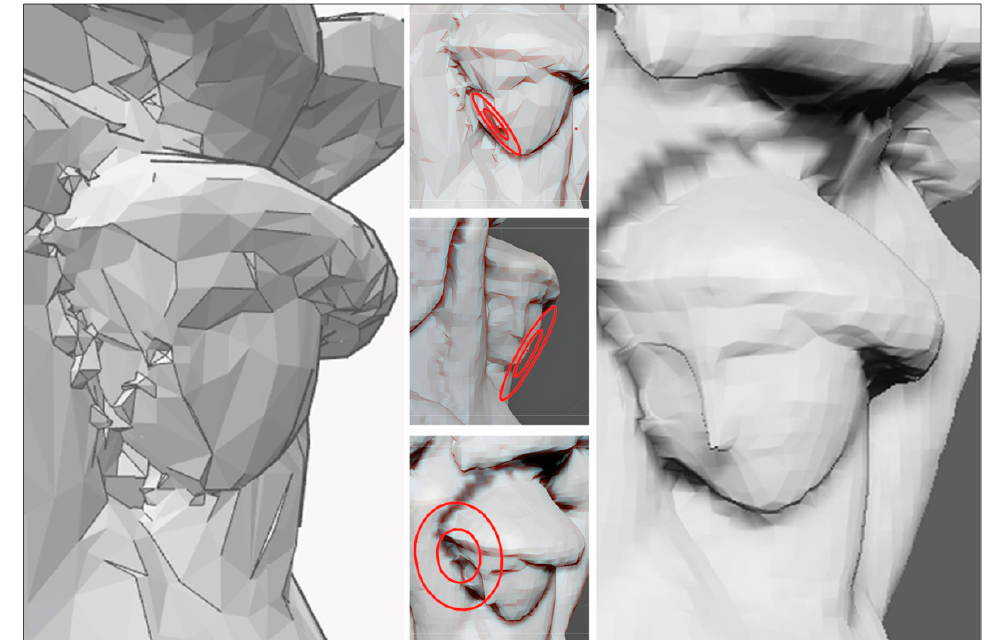
Figure 8. Second modelling phase: statue face with ZBrush. Details emerge as the modelling advances.